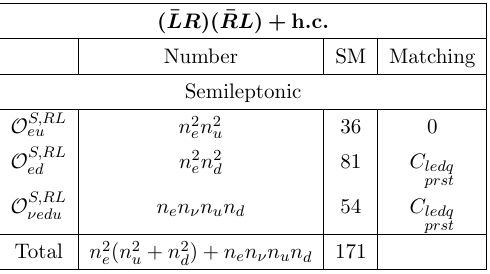
Table 16 . Dimension-six four-fermion operators: (¯ LR )( ¯ RL ) scalar bilinears in LEFT. There are also Hermitian conjugate operators, as indicated in the table heading. All of the operators are semileptonic operators. The second column is the number of operators for an arbitrary number of neutrino flavors n ν , charged lepton flavors n e , u -type quark flavors n u , and d -type quark flavors n d , and the third column is the number in the SM LEFT with n ν = 3, n e = 3, n u = 2, and n d = 3. The last column is the tree-level matching coefficient in SMEFT.